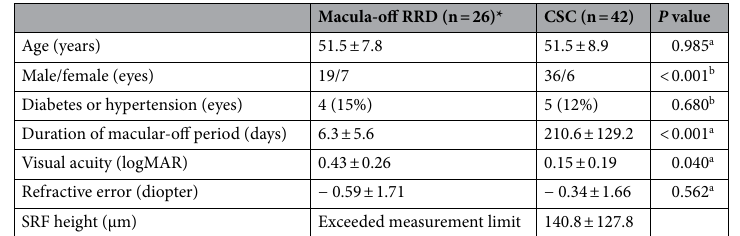
Table 1. Comparison of characteristics in macula-off rhegmatogenous retinal detachment and central serous chorioretinopathy. CSC central serous chorioretinopathy, RRD rhegmatogenous retinal detachment, SRF subretinal fluid. *Macula-off RRD patients who underwent optical coherence tomography angiography. a P values were calculated with independent t -test. b P values were calculated with chi-square test.